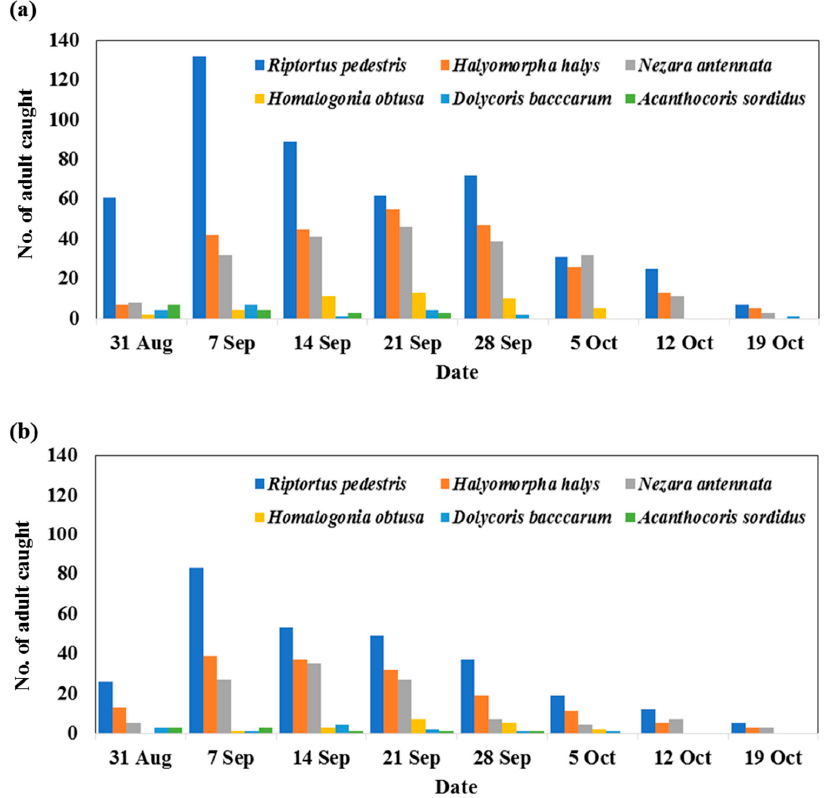
Figure 2. Change of density of stink bugs observed in soybean fields from 31 Aug to 19 Oct in Cheongju, Chungbuk province in 2021. Panel ( a ) is soybean field CJ-1 and panel ( b ) is soybean field CJ-2. Table 4. Comparison of injured soybean seeds and injury type caused by stink bugs on six soy- bean cultivars.